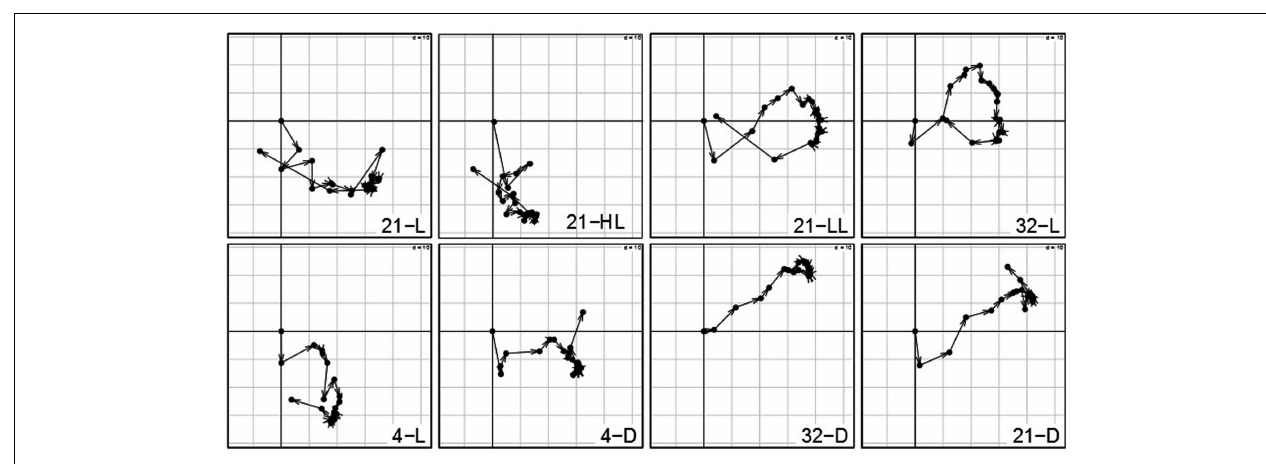
FIGURE 4 | Contributions of variables (i.e., time points 0–1280min) by projection of the corresponding columns on the first and second principal components for each condition (panel 1–8) obtained by using